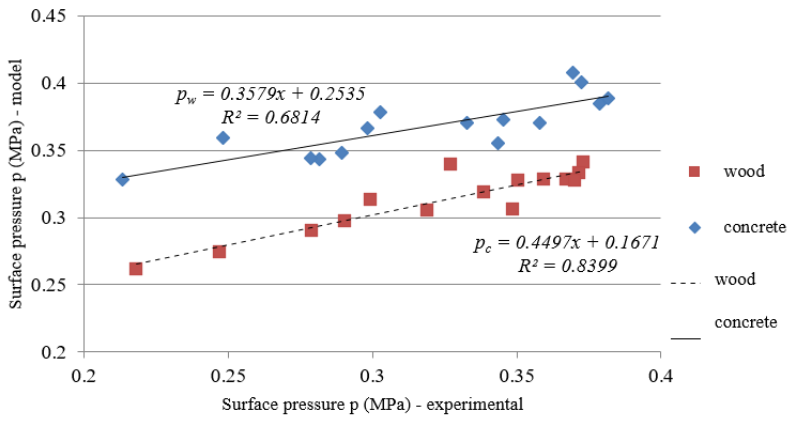
Figure 3. Comparison of average values of surface pressures obtained during the experimental tests and based on the numerical model. pw — means surface pressure for wood surface, pc — means surface pressure for concrete surface.